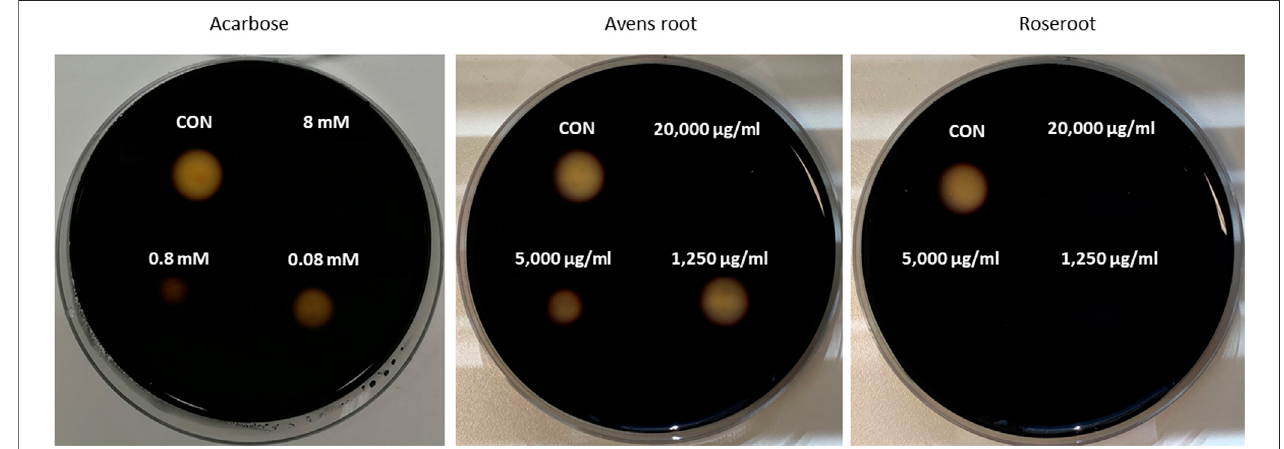
FIGURE1| Inhibitionofporcine α – amylase in-vitro activitybyrootextracts.Filterdiscs(diameterof0.5 cm)wereplacedonPetriplatesthatwere fi lledwithmedium containing1%agar-agar and 1%starch. Porcinepancreatic α -amylase was fi rstmixedwithdecreasingconcentrationsofthereference inhibitor acarbose,avensrootor roserootextract( fi nalconcentrationsareindicated)andthengivenontothe fi lterdiscs.Theplateswereincubatedovernightat37 ° C,beforethe fi lterdiscswereremoved. Following iodide-staining, the inhibition of α -amylase was calculated by comparing the diameter of the cleared zones of control fi lter discs (CON, α -amylase alone) with those of fi lter discs where the tested root extract or acarbose was added to α -amylase. The smaller the diameter of the cleared zone was, the stronger was the inhibition of the α -amylase activity. Exemplary results are